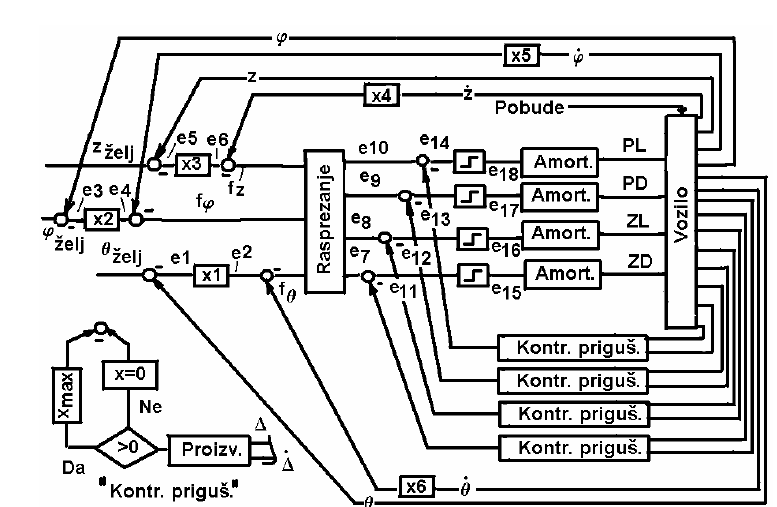
Figure 2 – Block sheme of the semi-active suspension